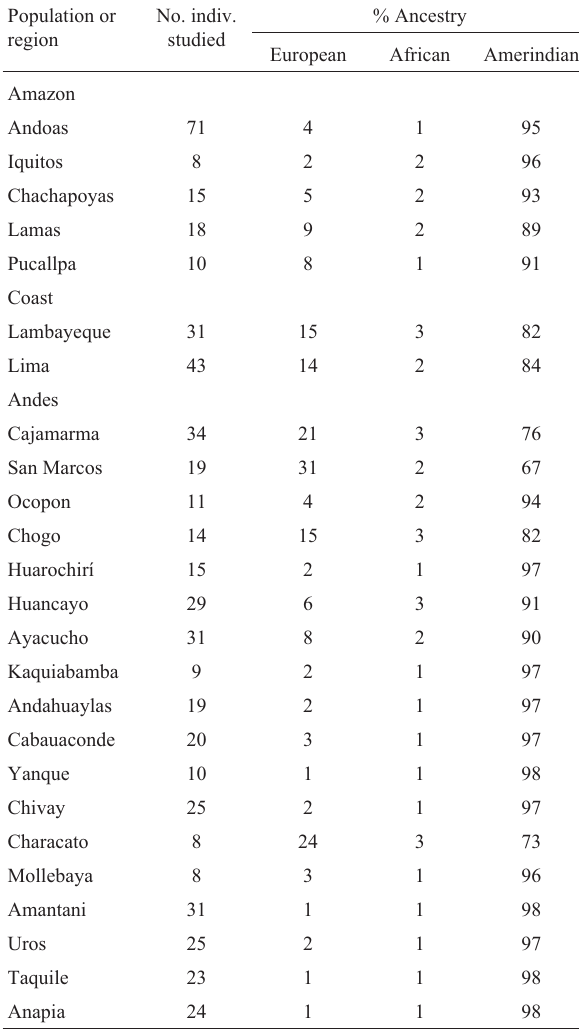
Table 5 - Molecular autosome estimates of parental continental ancestry in different segments of the Peruvian population 1 . Population or